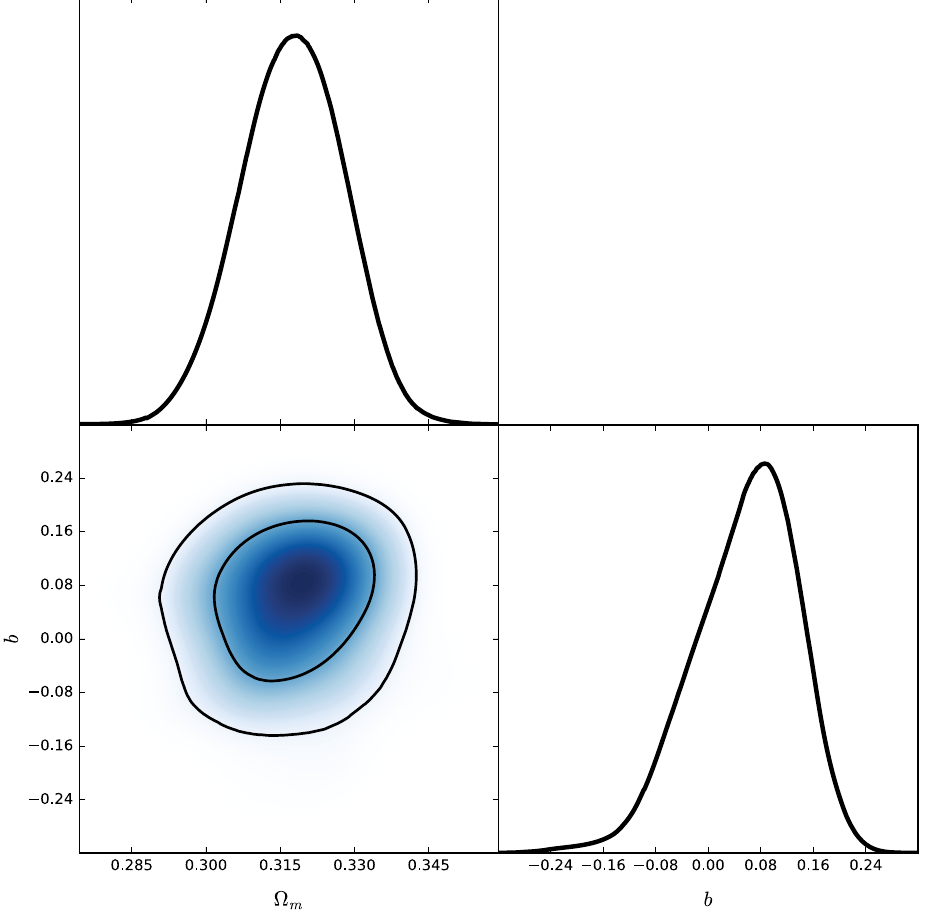
Fig. 2 The 68 and 95% confidence regions for the f 1 CDM model, which are constrained by the combined observational data of quasars, SN Ia, BAO and